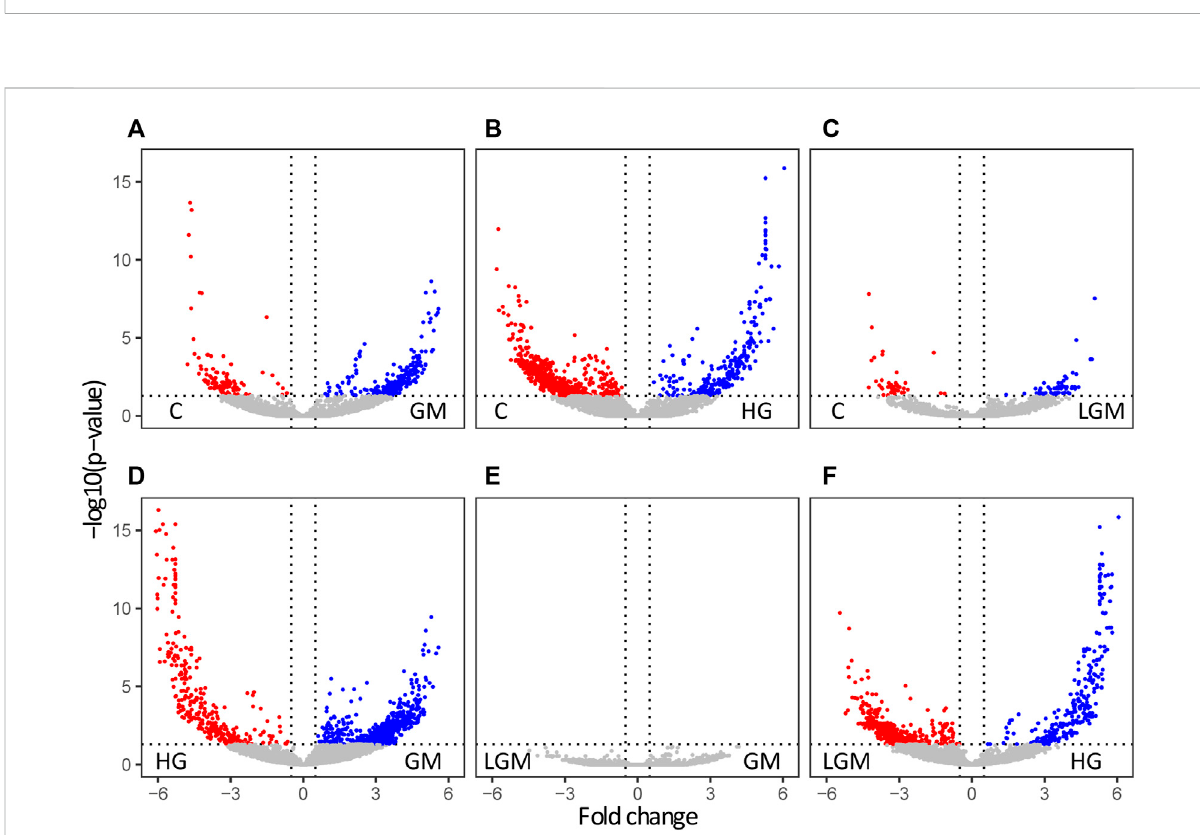
FIGURE 4 Treatment based signi fi cantly regulated features. Volcano plots of the signi fi cant features in pairwise comparisons of the different treatments. The data are plotted as − log10 ( p -value) against the log2-fold change. Signi fi cantly regulated metabolites are highlighted in red and blue. Panels (A – C) showthesigni fi cantlyregulatedfeaturesofthecomparisonsGM/HG/LGMvs.C,panel (D) thecomparisonofGMvs.HG, (E) thecomparisonof GM vs. LGM, and panel (F) HG vs.